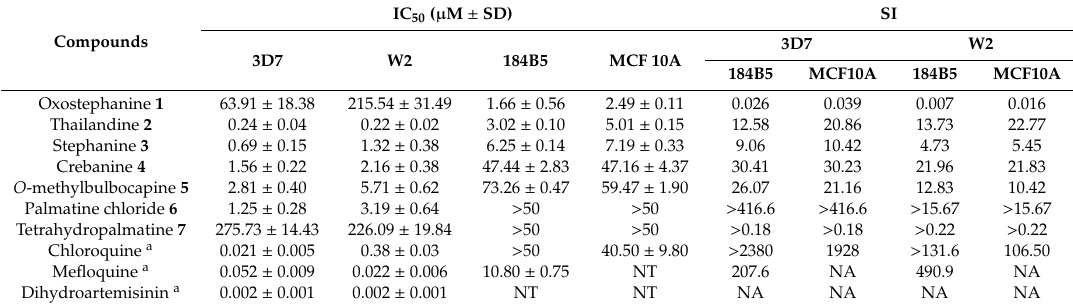
IC 50 values of the compounds isolated from MB2L-CH and MB2L-B against Plasmodium falciparum 3D7 and W2 strains, and 184B5 and MCF10A non-cancer cell